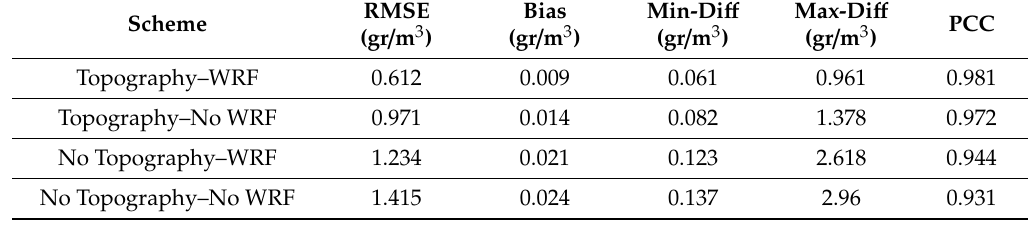
Table 2. Statistical comparison between the obtained WVD and radiosonde data.